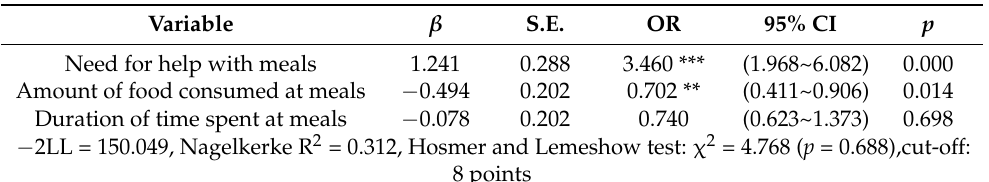
Table 11. Odds ratio estimates of the need for help with meals, amount of food consumed at meals, duration of time spent at meals, and depression status. Variable β S.E. OR 95% CI p Need for help with meals 1.241 0.288 3.460 *** (1.968~6.082) 0.000 Amount of food consumed at meals − 0.494 0.202 0.702 ** (0.411~0.906) 0.014 Duration of time spent at meals − 0.078 0.202 0.740